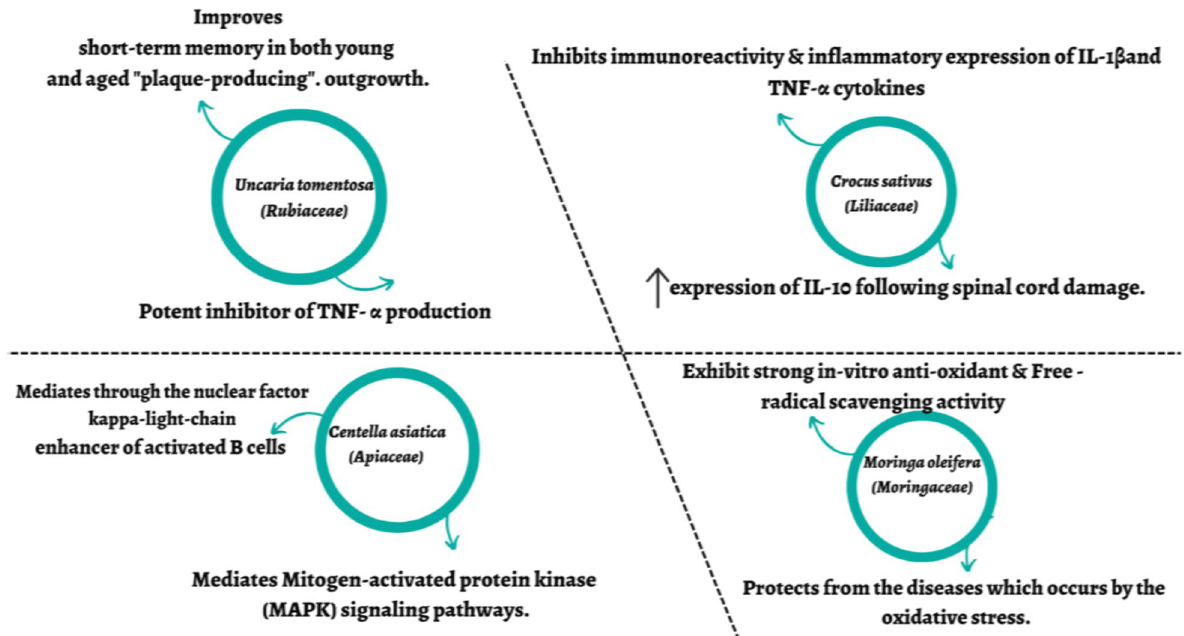
Fig. 7 Neuroprotective mechanism of action of neuro-nutraceutical